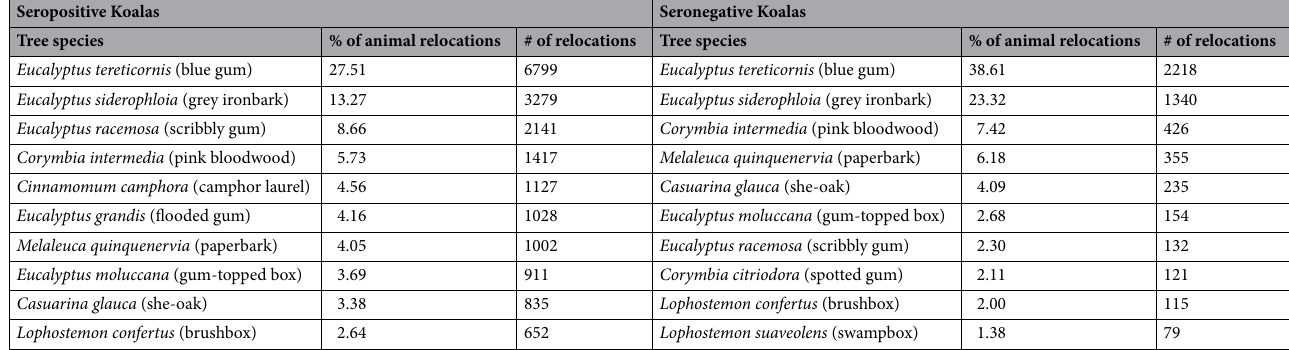
Table 5. Common tree species used by Ross River virus seropositive and seronegative koalas across both study areas. Tree use is represented by the percentage (mean) of animal relocations during which a koala was observed on an individual tree